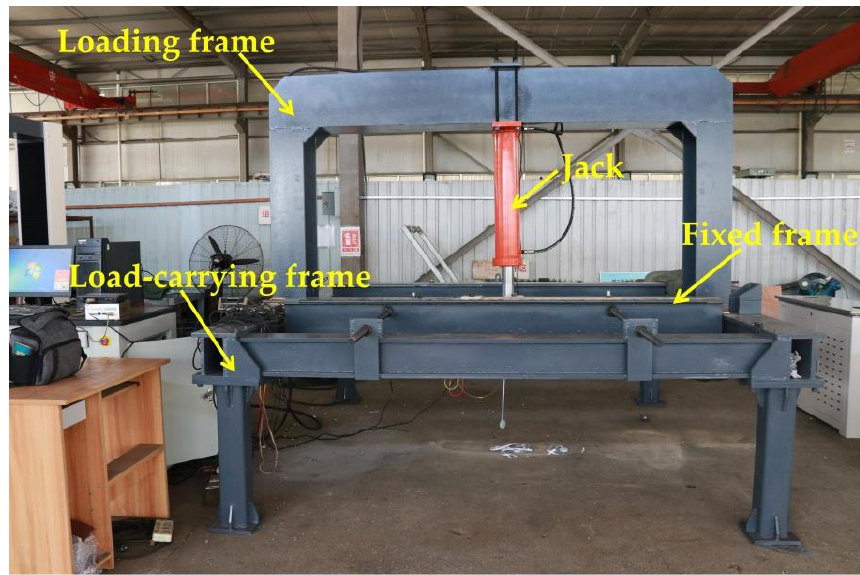
Figure 8. Partial specimen mounting.